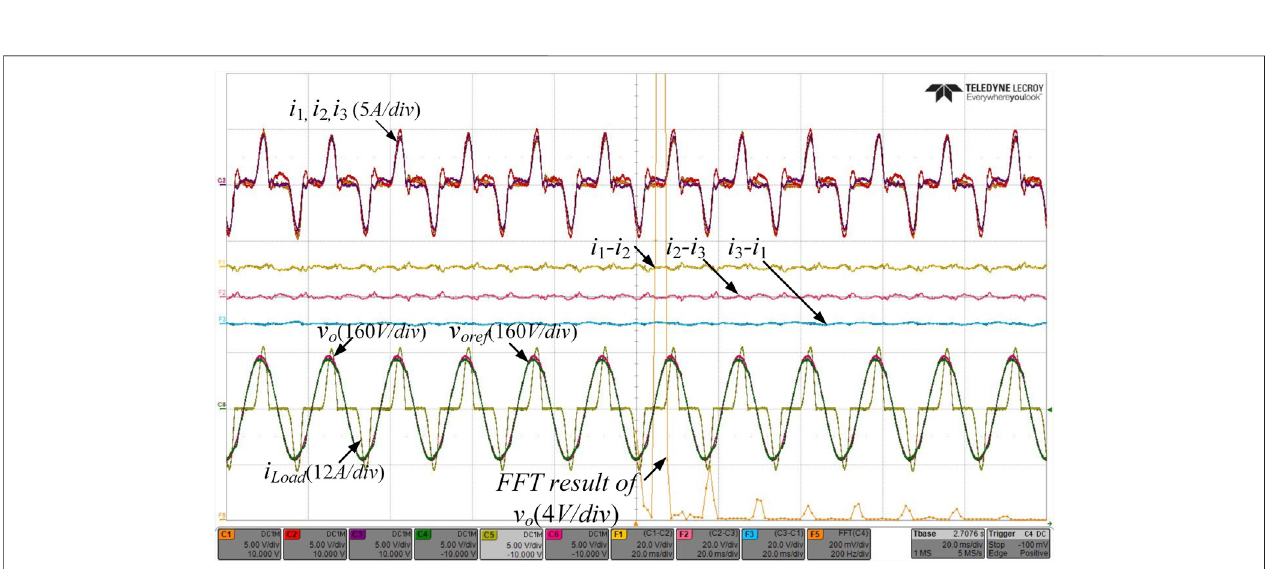
FIGURE 17 | Nonlinear load under unbalanced condition (L 1 (cid:1) 1mH, L 2 (cid:1) L 3 (cid:1) 2 mH).